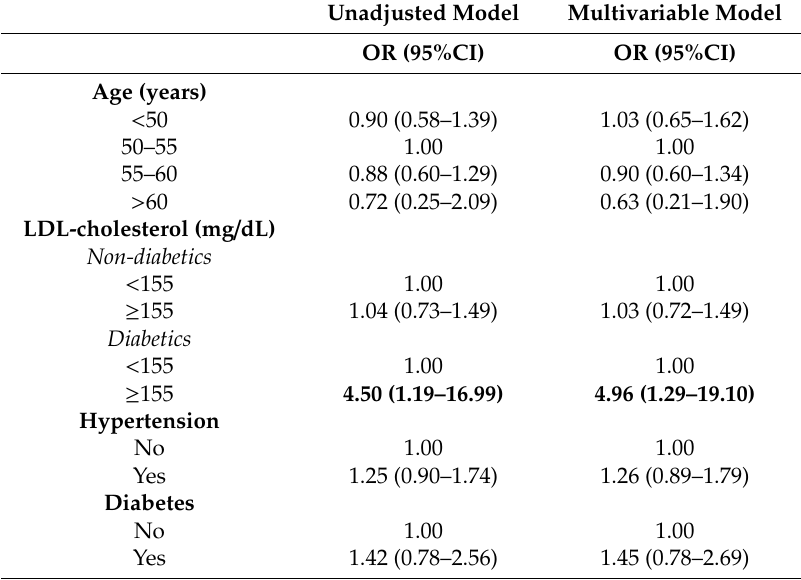
Table 3. Association between sociodemographic, analytical, clinical, and lifestyle factors and the prescribing of a high-intensity statin in the study population: logistic regression analyses (N =